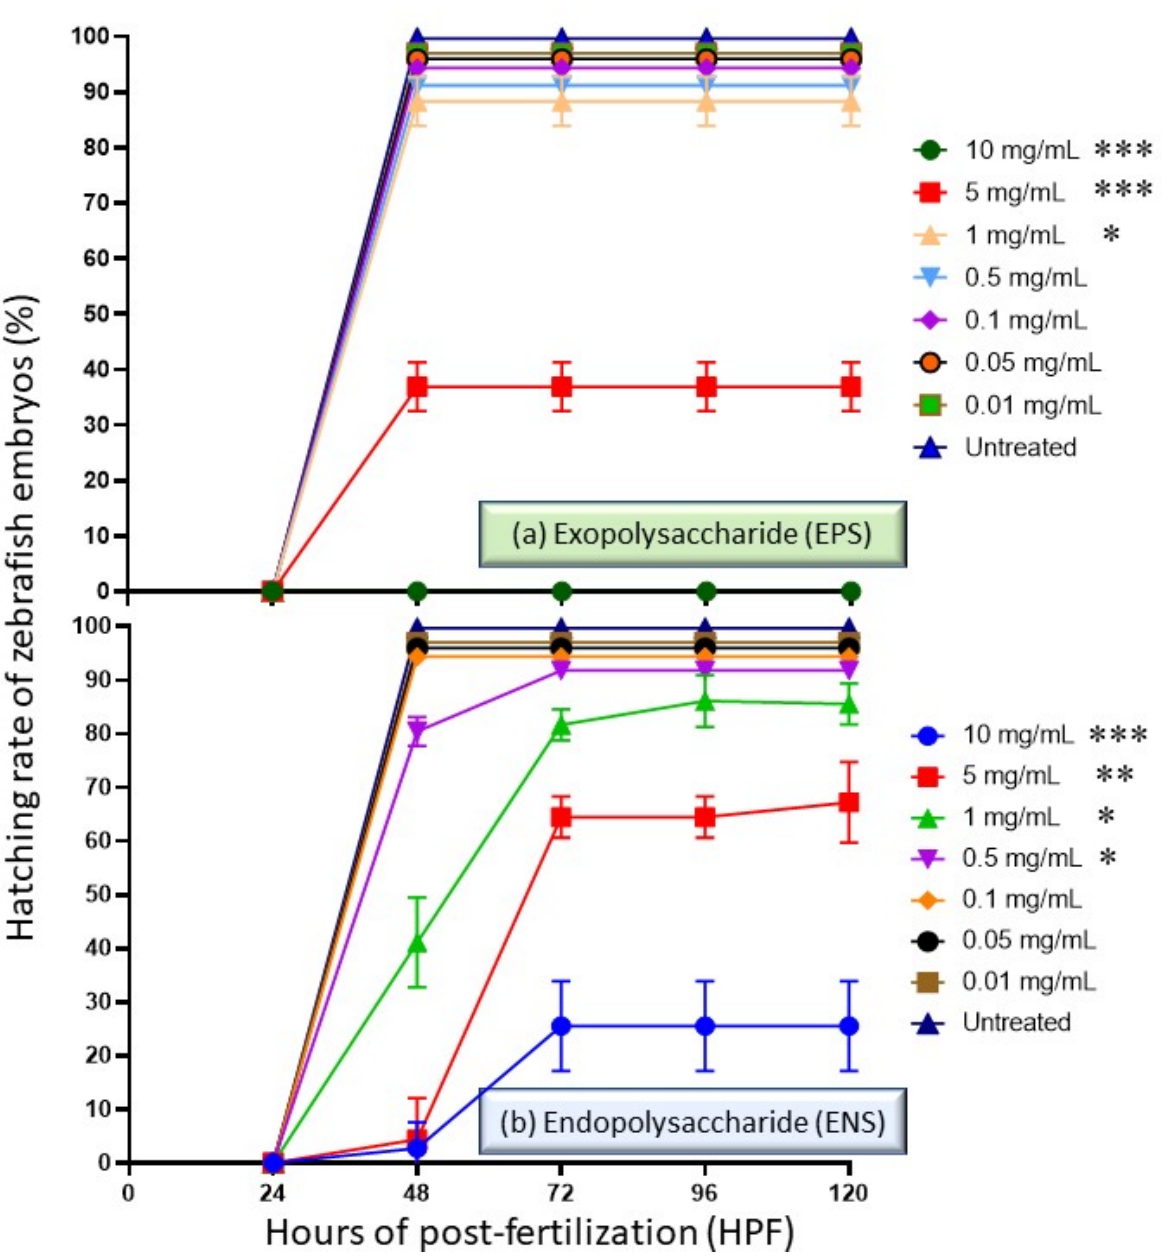
Figure 3. Hatching rate of zebrafish embryos at 0 to 120 h of post exposure with Ganoderma applanatum EPS and ENS extract at concentrations of 0.01–10 mg/mL. ( a ) For EPS, low hatching rate (<40%) was observed at concentration 5.0 mg/mL due to high mortality rate. Meanwhile, ( b ) for ENS, low hatching rate (<30%) was observed at concentrations 10 mg/mL due to high mortality rate. High hatching rate was observed at concentrations >1.0 mg/mL (>80%). Symbols: * p < 0.05, ** p < 0.01 and *** p < 0.001.